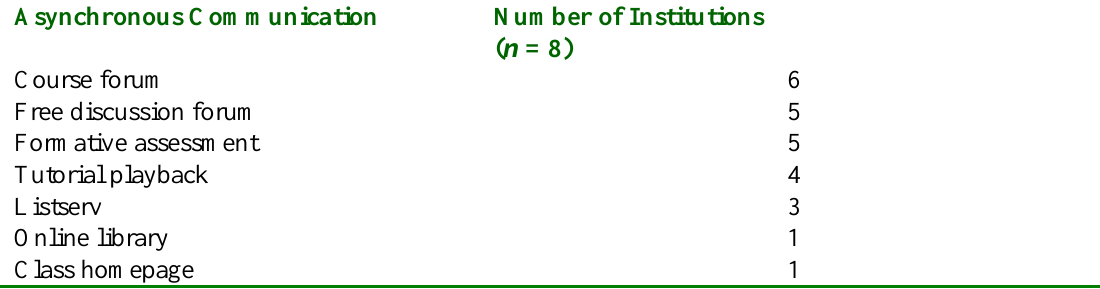
Table 3. Provision of asynchronous communication in learner support reported by the eight institutions Asynchronous Communication